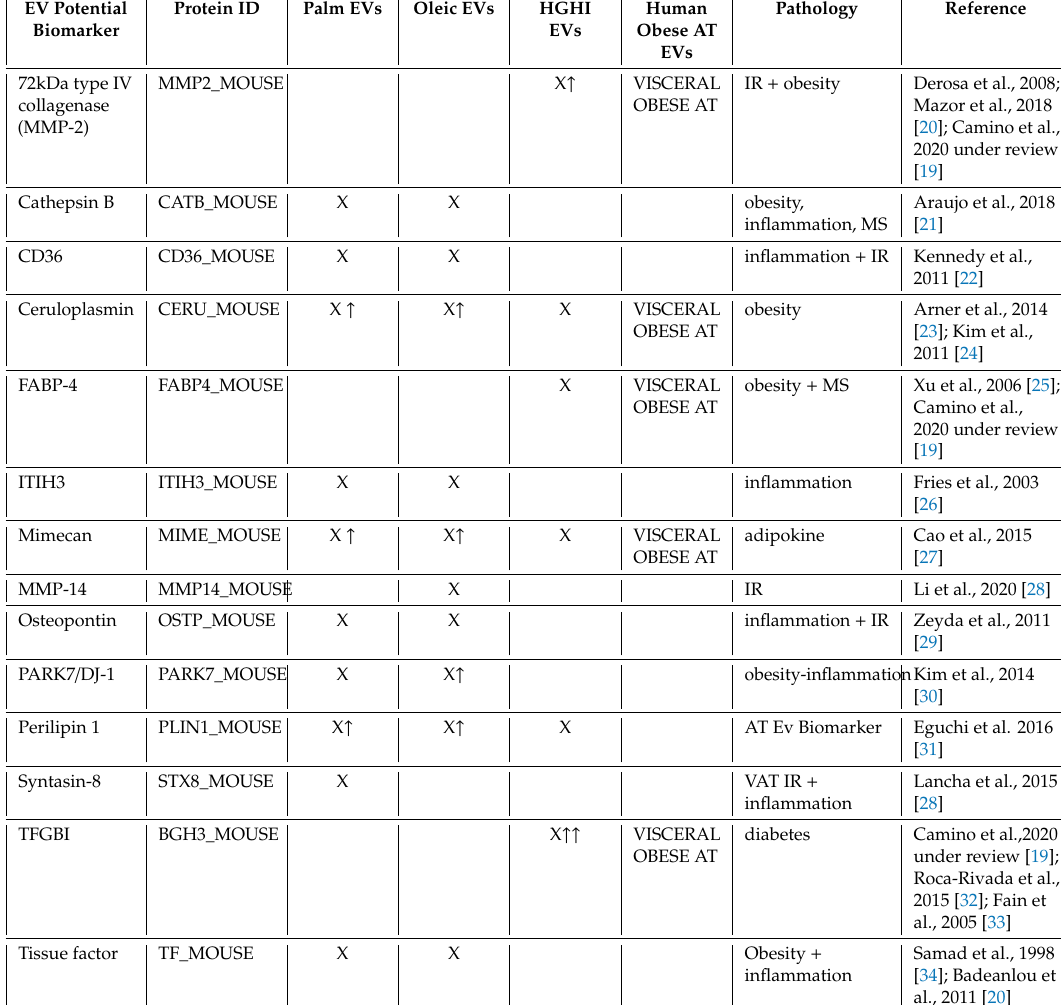
Table 1. List of suggested potential EV biomarkers for pathological adipocytes. Selected proteins identified in the proteomics analysis are suggested as EVs biomarkers based in the bibliography and in previous analysis performed by us in EVs from human obese adipose tissue (Camino et al., under review). Up-arrow: up regulated; down-arrow: down regulated in the SWATH analysis. IR: insulin resistance; MS: metabolic syndrome; AT: adipose